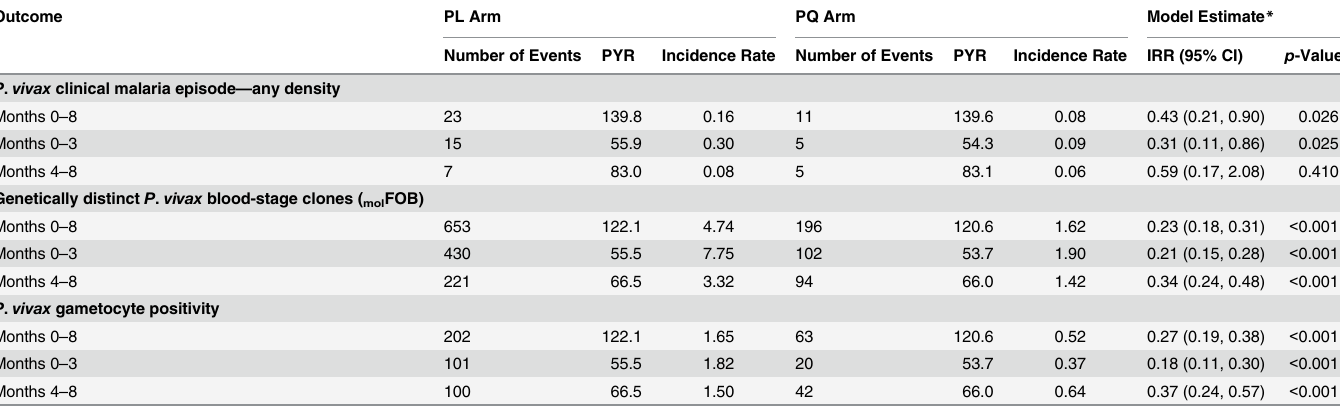
Table 3. Incidence rate of P . vivax clinical malaria of any density, genetically distinct P . vivax blood-stage clones, and gametocyte positivity in treatment groups during the entire 8-mo follow-up period and separately for months 0 – 3 and 4 – 8 of follow-up. Outcome